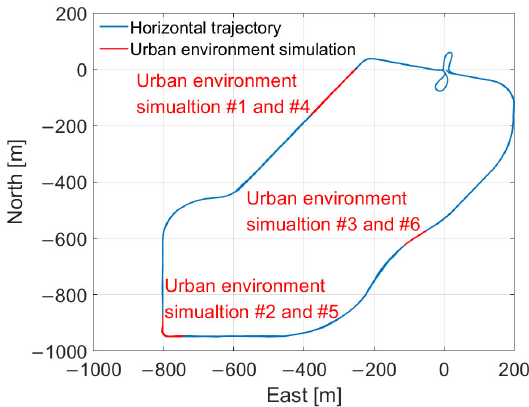
Figure 5. Two ‐ dimensional experiment trajectory. Figure 5. Two-dimensional experiment trajectory. Table 1. The LOS multipath and the NLOS reception error simulation settings. Table 1. The LOS multipath and the NLOS reception error simulation